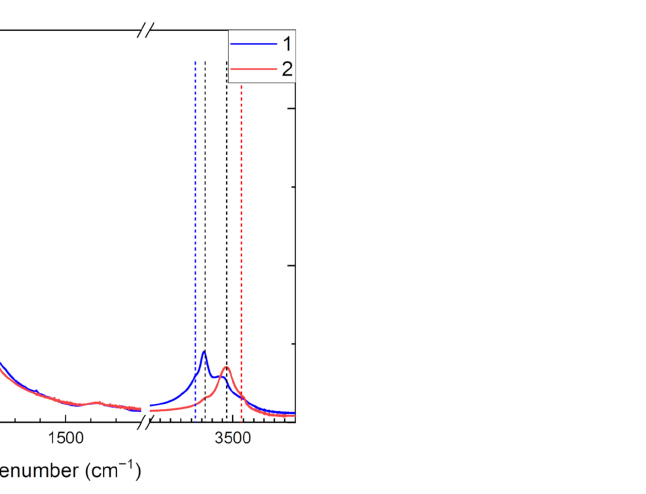
Figure 5. Infrared absorption spectra of tinaksite ( 1 ) and tokkoite ( 2 ). Vertical lines point positions of Ti-related and OH − stretching bands. Table 2. Infrared band positions and suggested assignments of the observed bands in the lattice region of tinaksite and